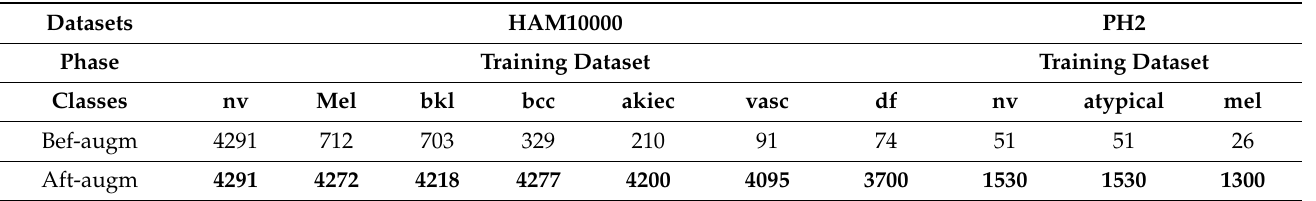
Table 2. Balancing and augmentation of dermoscopic image data for the two datasets of skin lesions, HAM10000 and